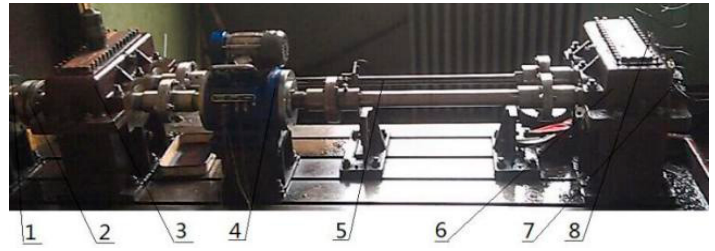
Figure 25. Experiment platform. 1—Speed-adjustable motor, 2—Coupling, 3—Accompanied gearbox, 4—Speed reversing instrument, 5—Torsion bar, 6—Test gearbox, 7—Acceleration sensor 1#, and 8—Acceleration sensor 2#.